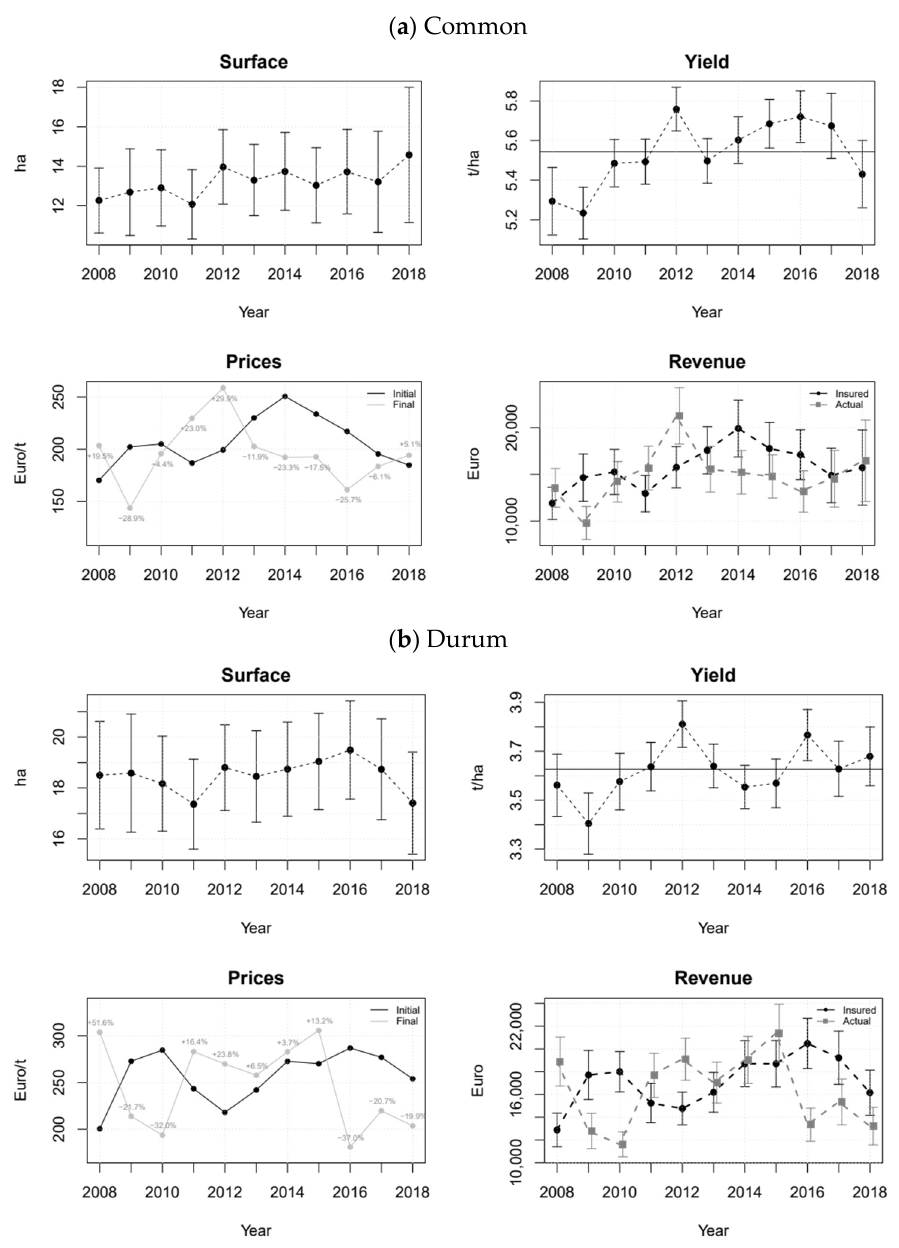
Figure 1. Cultivated surface (top left panel), actual yield with line of insured yield averaged over considered period (top right), initial and final prices (bottom left), and insured and actual revenues (bottom right) for farms growing common ( a ) and durum ( b ) wheat. Mean and 95% confidence interval are